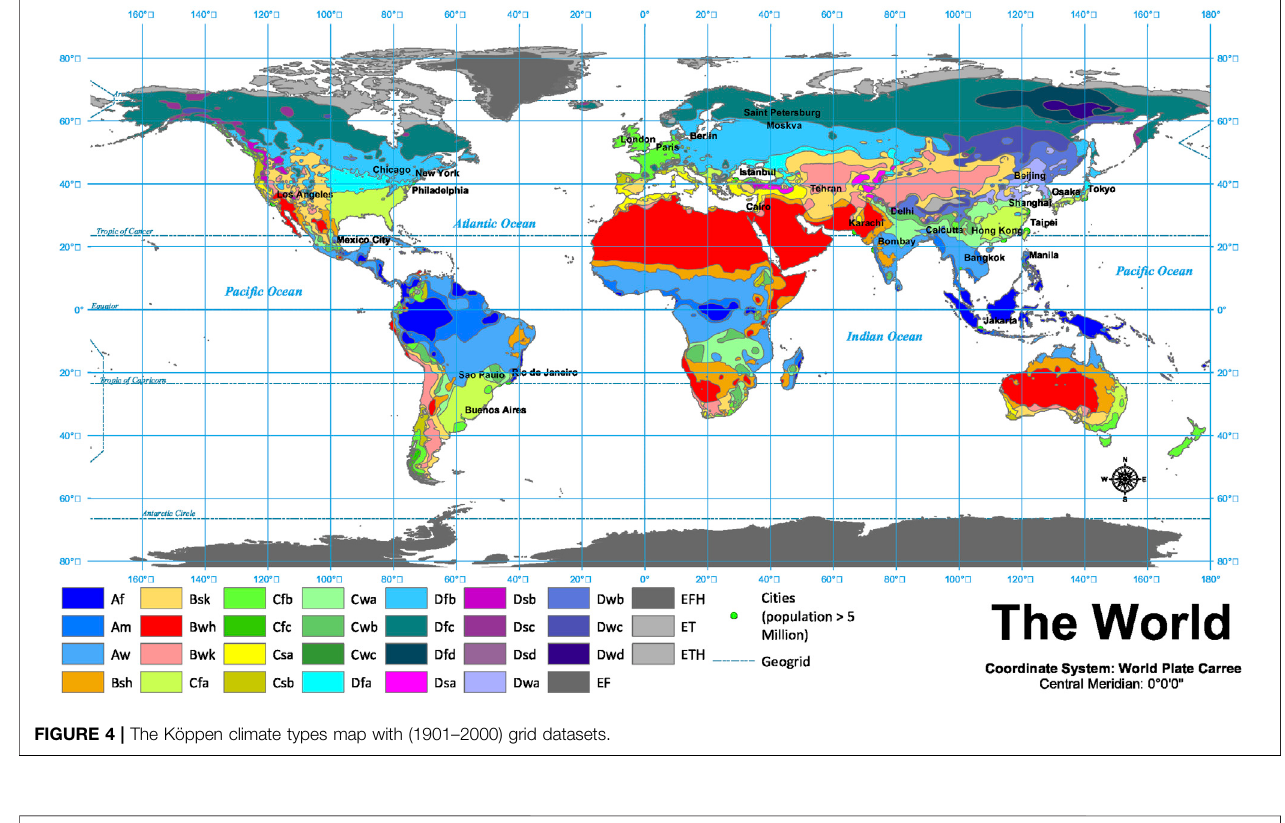
FIGURE 4 | The Köppen climate types map with (1901 – 2000) grid datasets.